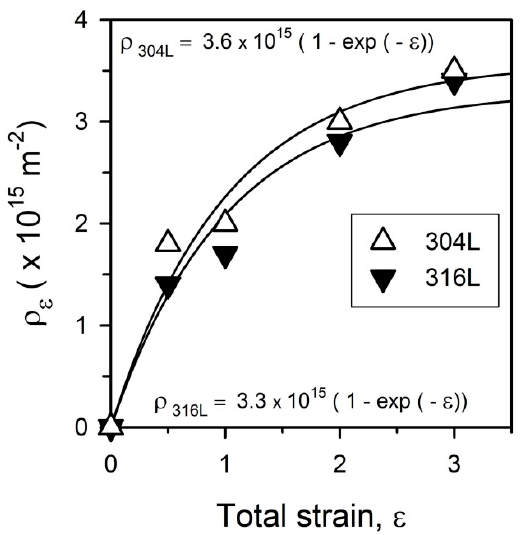
Figure 14. The e ff ect of rolling at 473 K on the dislocation density ( ρ ε ) in 304L and 316L stainless steels.